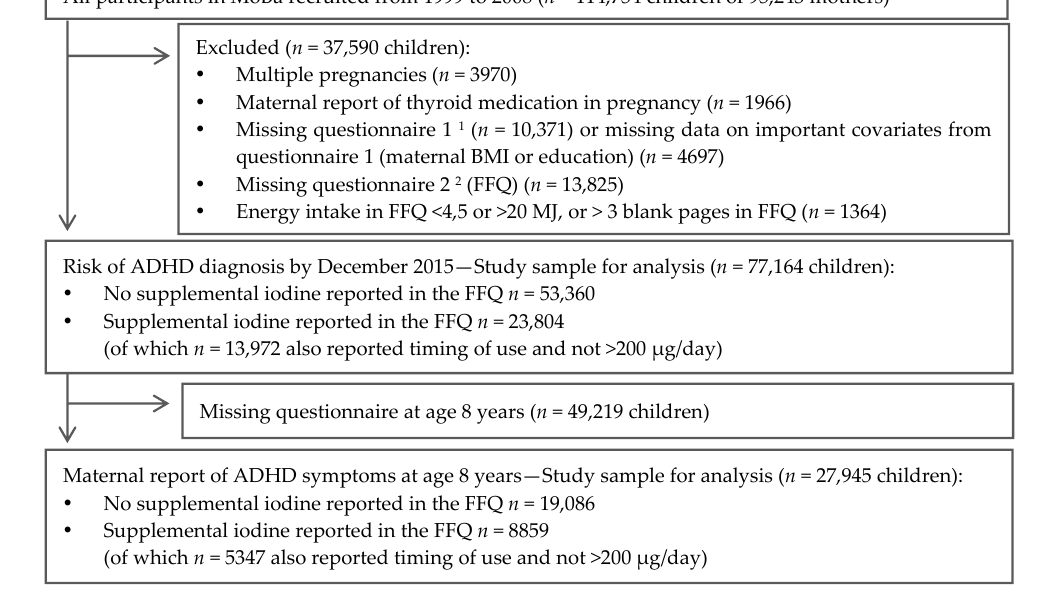
Figure 1. Flow-chart of inclusion. 1 Questionnaire 1 was answered around gestational week 17. 2 The